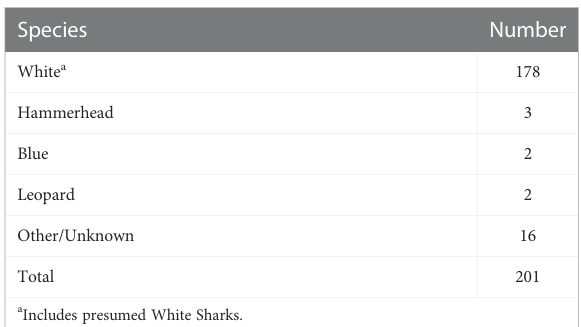
TABLE 2 Species composition of California shark incidents between 1950 and 2021.